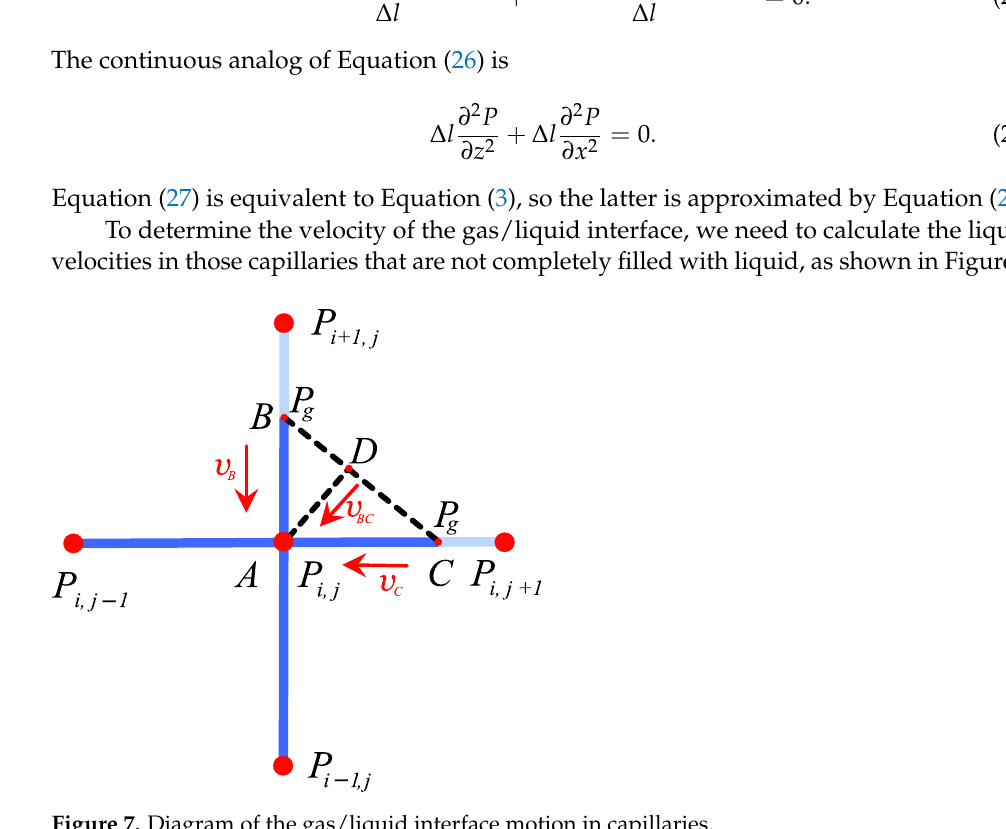
Figure 7. Diagram of the gas/liquid interface motion in